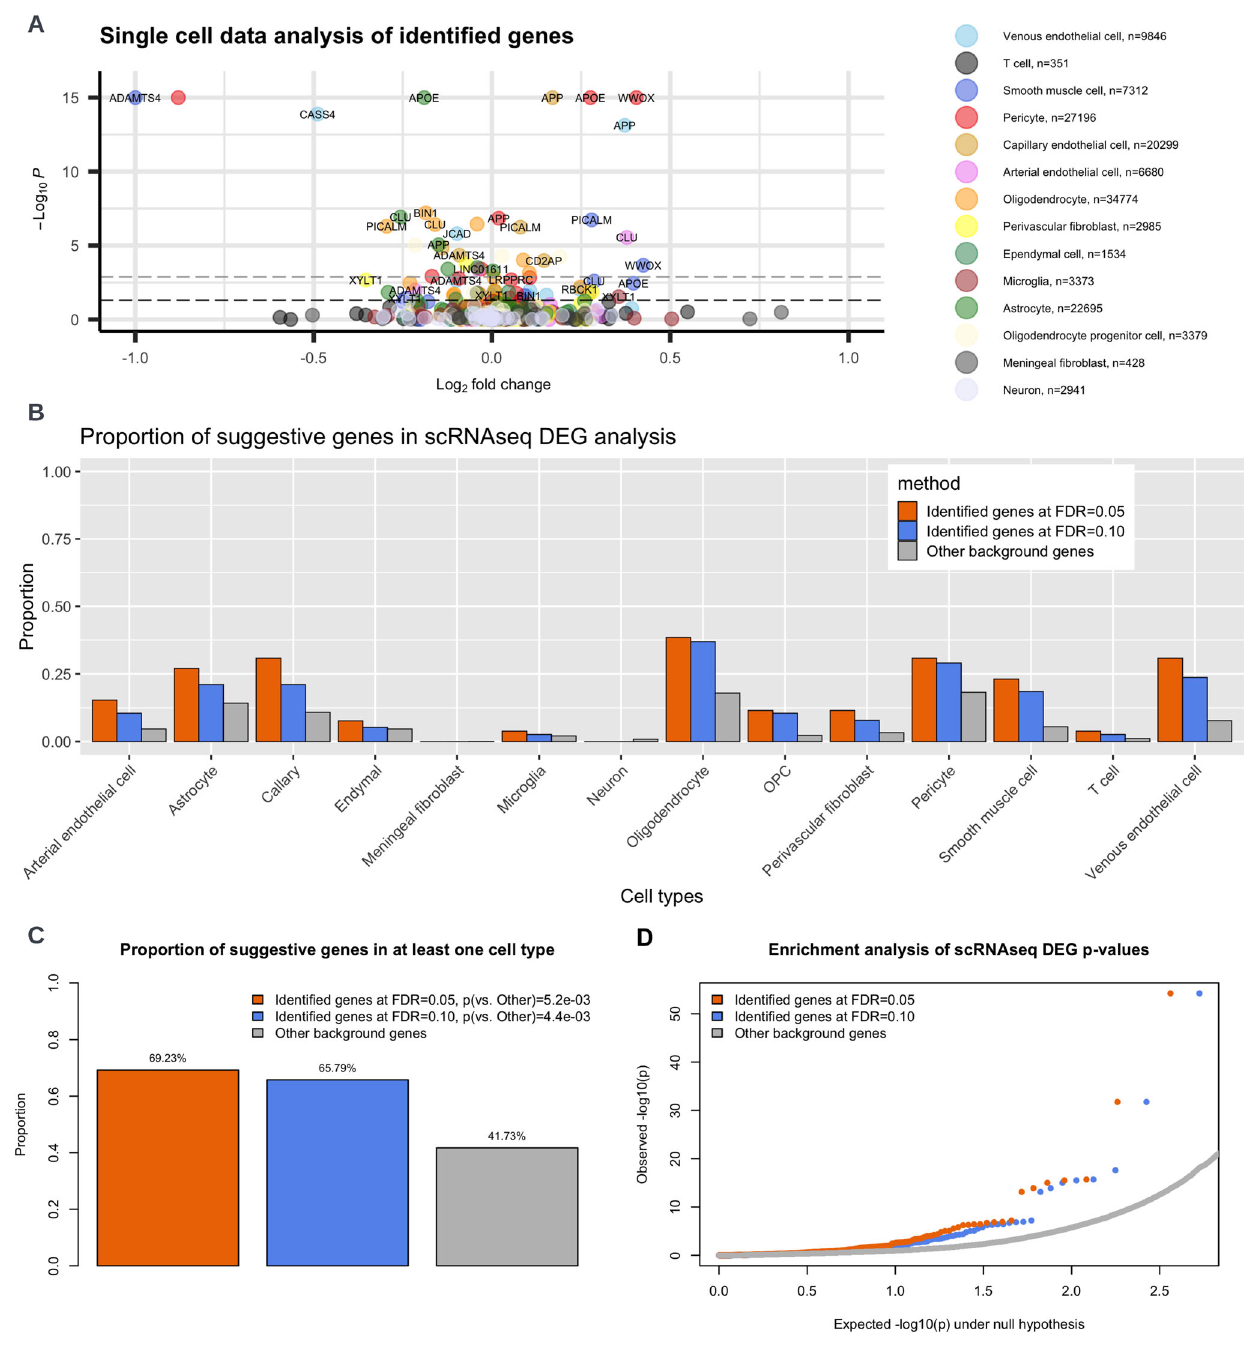
− log10( p ) values are capped at 15 and abs(log2(fold change)) values are capped at 1.0. Positive log2 fold change corresponds to higher expression level in AD. B Proportionofsuggestivegenesstrati fi edbycelltypes. C Proportionofsuggestive genes in at least one cell type. P -values arecalculated with two-sided Fisher ’ s exact test. D Enrichment analysisof DEG nominal p -values relative to background genes. P -values are calculated by MAST implemented in